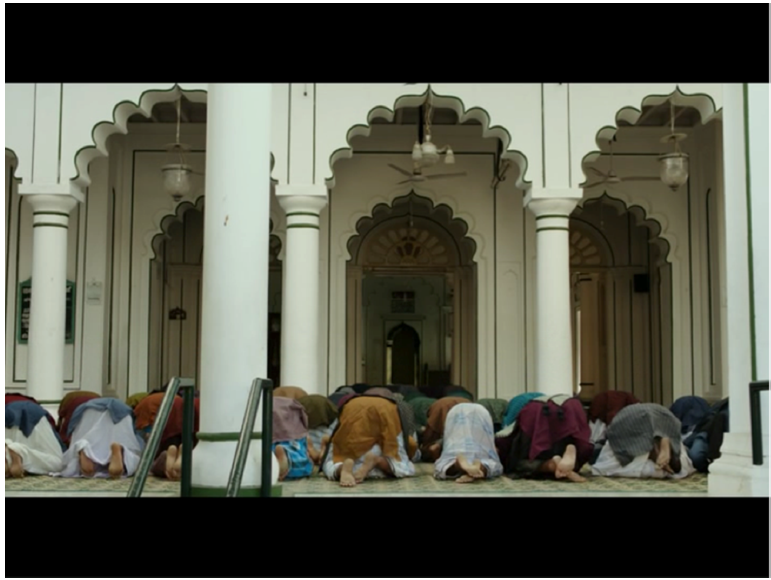
Figure 2. Muslims at prayer, inserted digitally via blue screen.